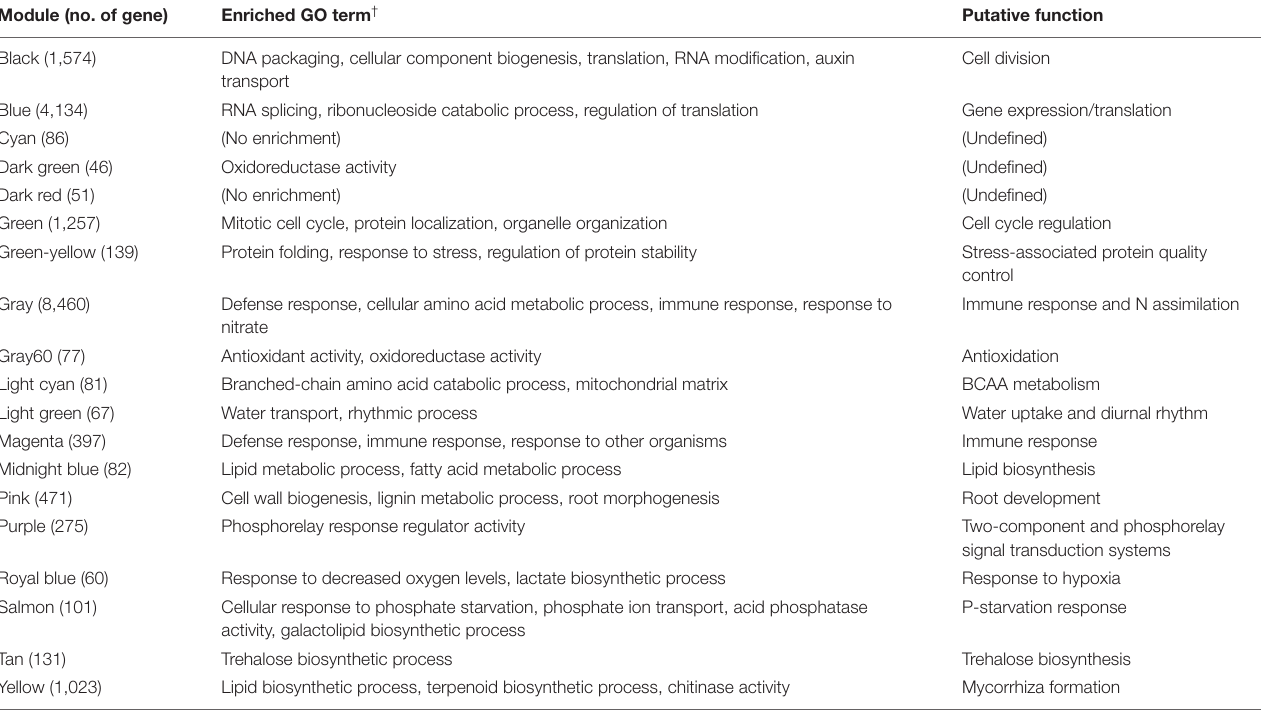
TABLE 1 | Enriched Gene Ontology (GO) terms and putative function of gene coexpression modules. Module (no. of